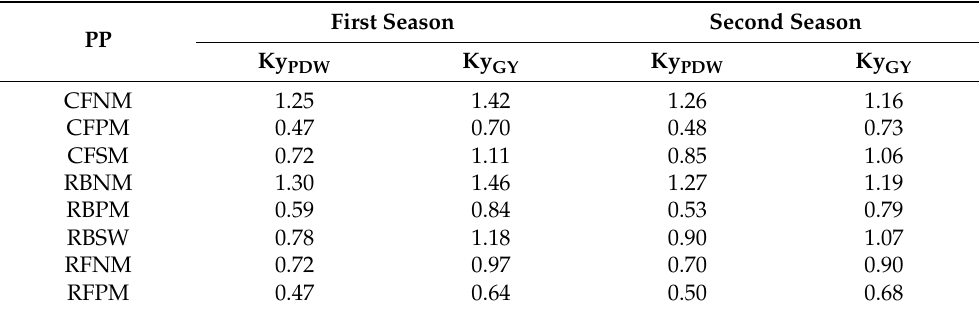
Table 3. Yield response factor (ky) shown as the relationship between the relative biomass decrease (Ky PDW ) and relative grain yield decrease (Ky GY ) and the corresponding relative evapotranspiration for different combination of planting patterns (PP) and mulching under 0.50 ET treatment in two growing